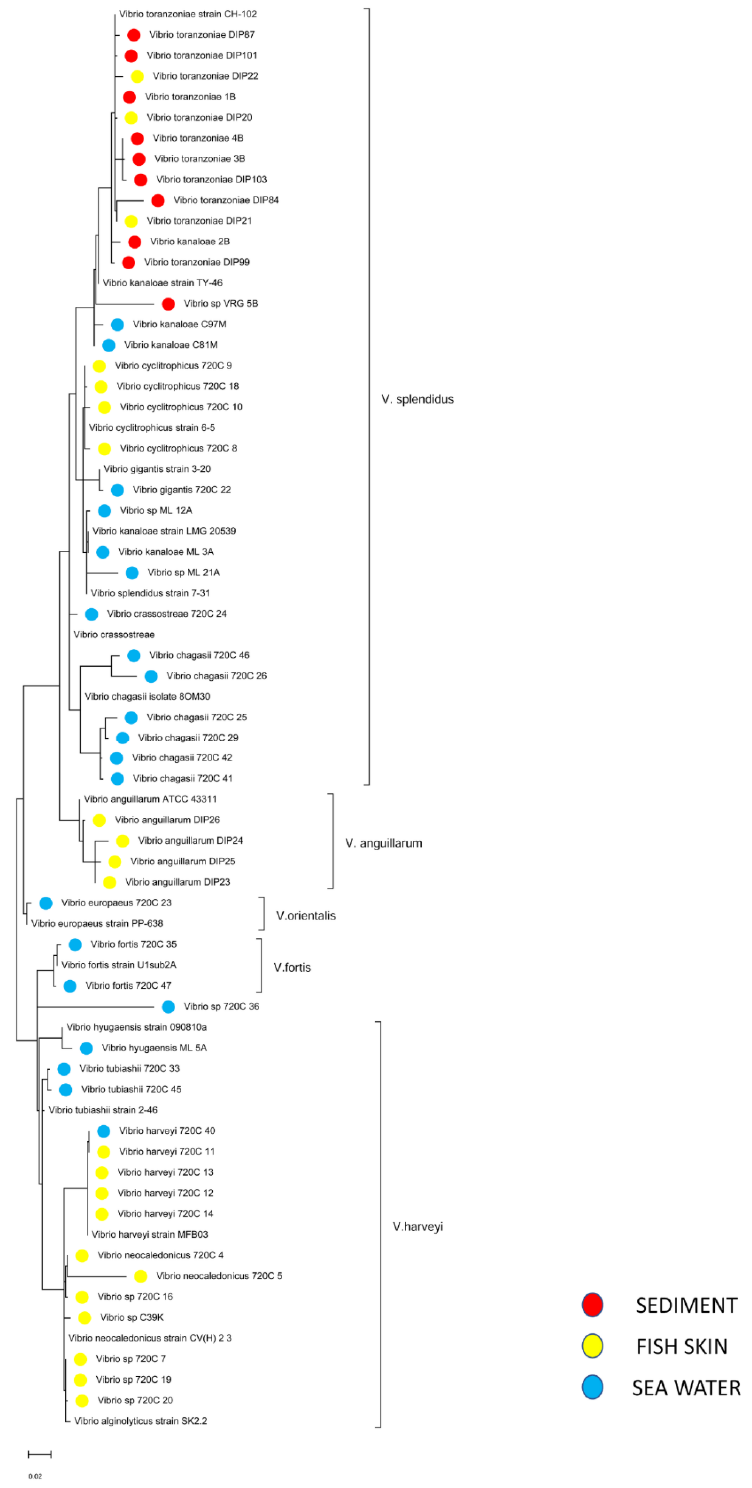
Figure 6. Phylogenetic analysis of studied Vibrio species that was inferred from partial 16S rRNA gene sequences using MEGA11 software—the clades are indicated by brackets.